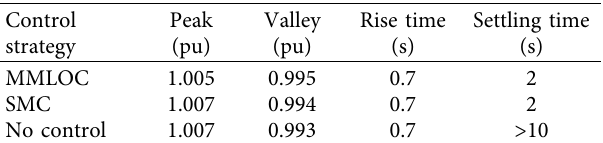
Table 3: Te performance index rotor speed under three-phase fault.